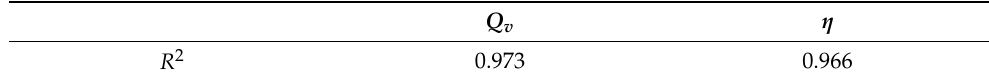
Table 2. Ensemble of surrogates model R 2 .